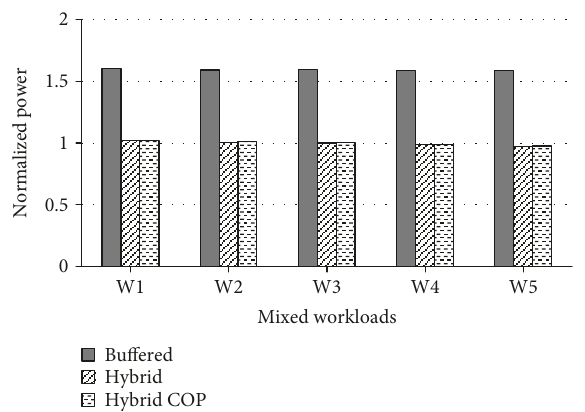
Figure 18: Normalized IPC of 128 threads with two threads per